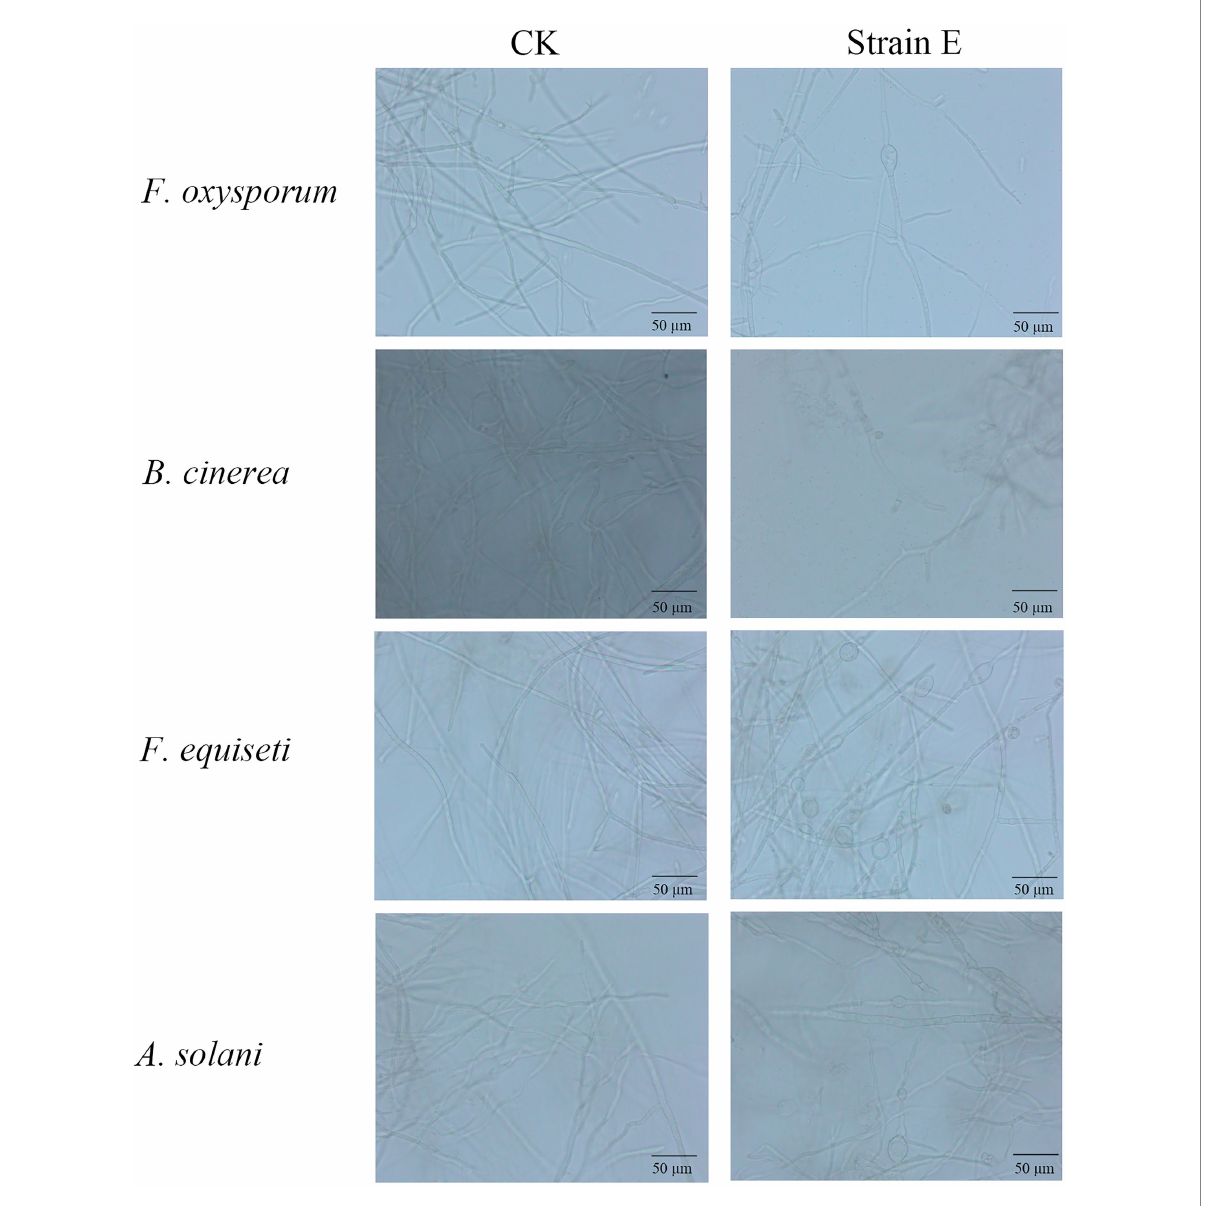
FIGURE 2 Morphological changes observed in hyphae of fungal pathogens after treatment with strain E. LB broth was used as a